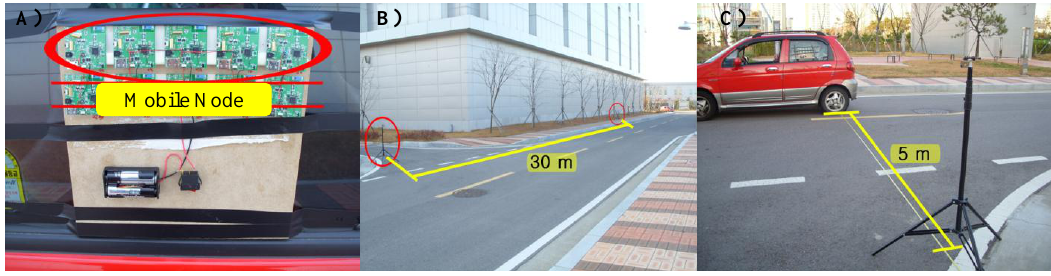
Figure 12. Setup used to evaluate the successful packet transfer rate according to changes in the mobile nodes’